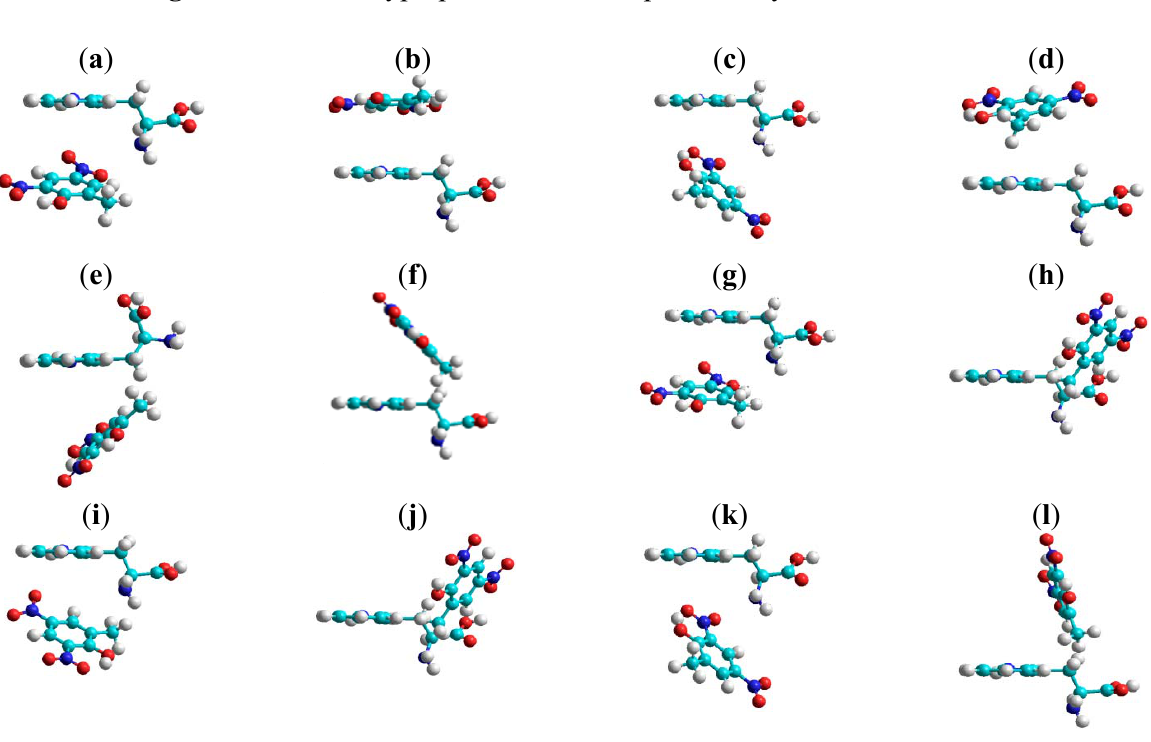
Figure 5. DNOC:Tryptophan structures optimized by the PM3 method.